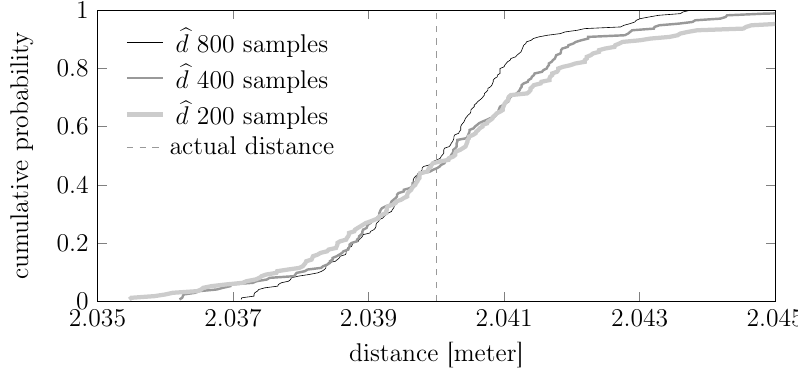
d for different testing sample sizes. The device (cid:98)